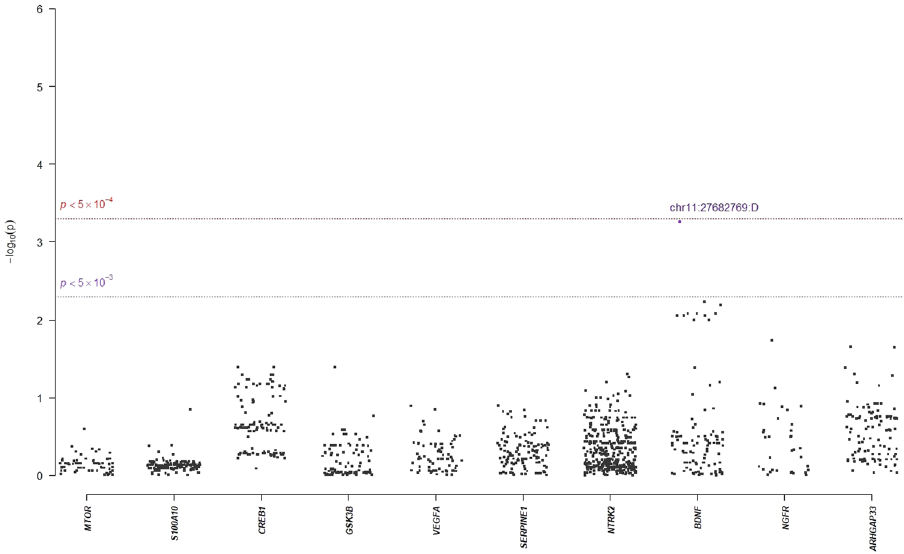
Figure 2. Manhattan plot of mega-analysis of selected candidate genes for Remitted